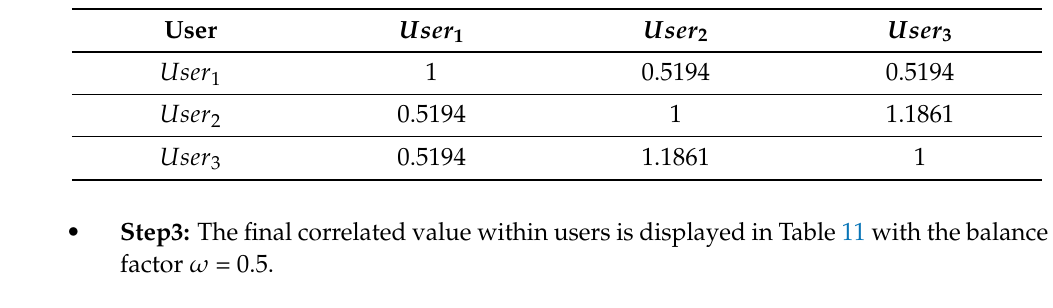
Table 11. User’s similarity value.